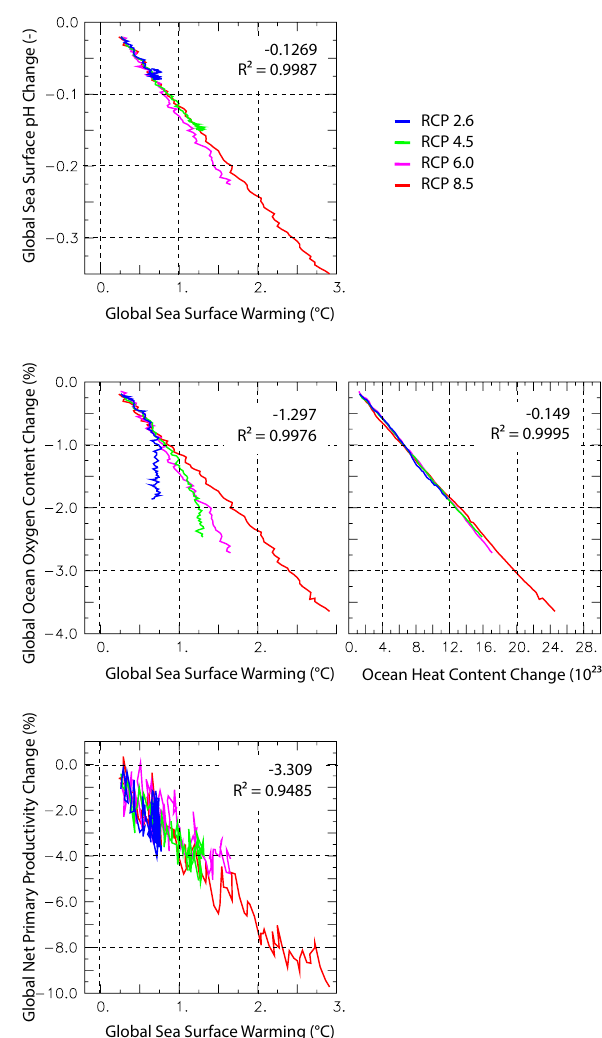
Fig. 11. Relations between model-mean changes in surface pH (pH unit), global O 2 content (%) and global NPP and model-mean sea surface warming ( ◦ C) for all scenarios. For global O 2 con- tent, changes are also plotted against changes in total heat content (10 22 J). All changes are relative to 1990–1999 and plotted over